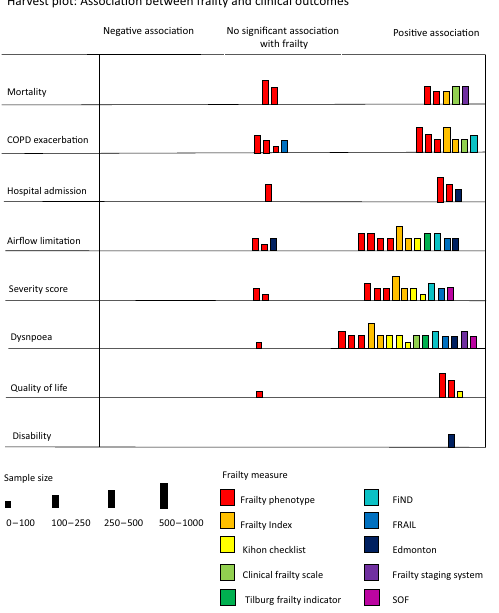
Fig. 5 Harvest plot showing the relationship between frailty and clinical outcomes in the included studies. Each bar represents a single study. Colour is used to indicate which frailty measure is used. Height of the bar indicates study sample size. The position of the bar on the matrix indicates the relationship between frailty and the outcome in question (positive association between frailty and the outcome, no signi fi cant association, or negative association between frailty and the outcome [i.e. frailty is protective]).